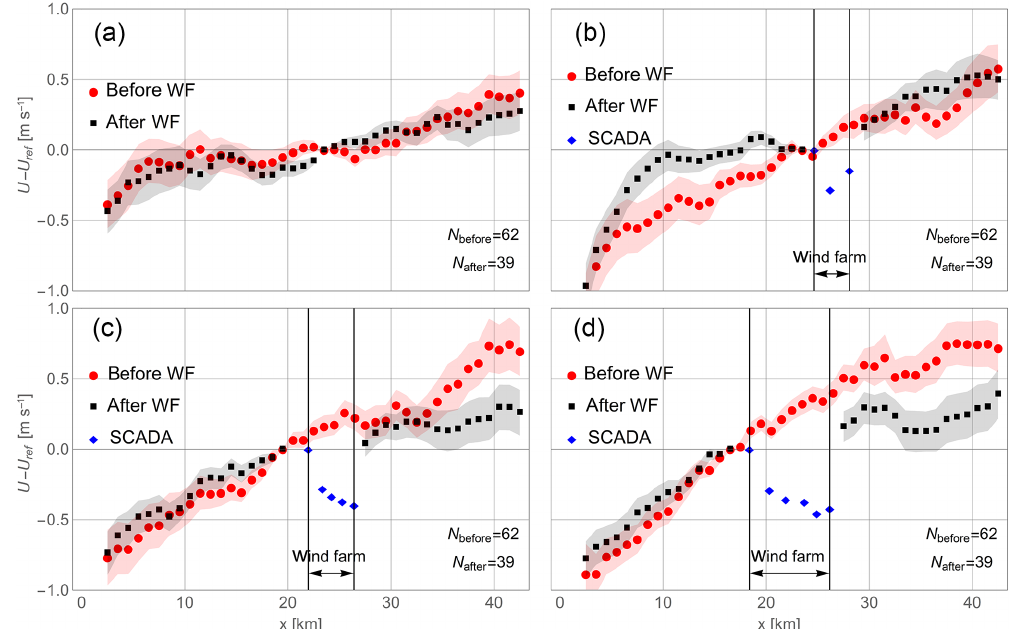
Figure 13. Wind speed differences from SAR along transects a to d before and after construction of the wind farm. Differences calculated from SCADA wind speeds are also shown and the position of the wind farm is